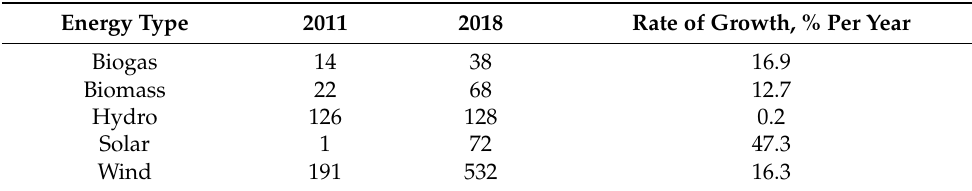
Table 7. Installed capacity of RES power plants in Lithuania during 2011–2018, MW (designed by the authors, based on